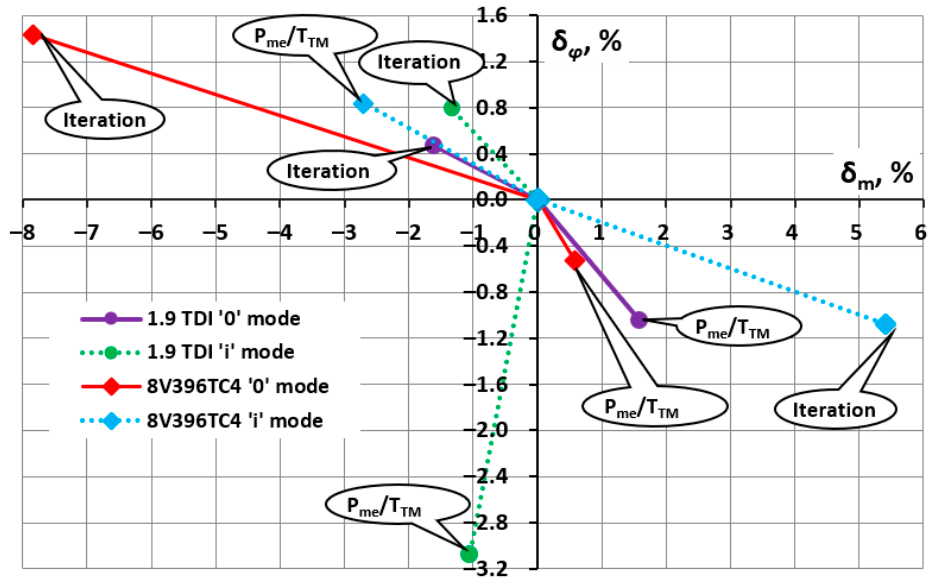
Figure 9. Comparison of m and ϕ z parameters evaluated using reverse modified and iteration methods with reference ( T TM / P me ).